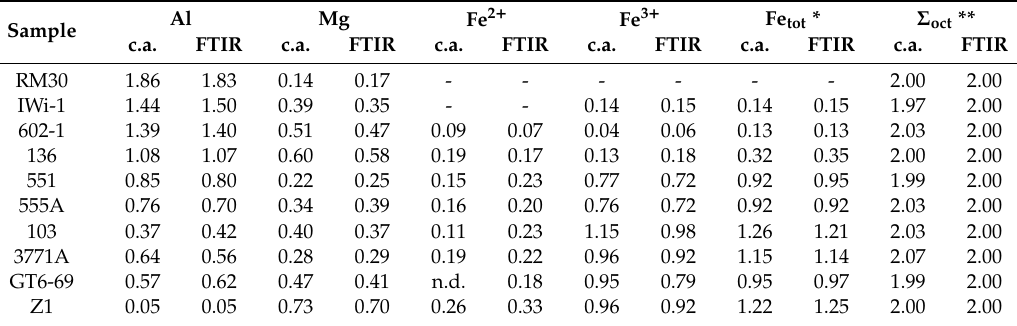
Table 6. Octahedral cation compositions of selected samples (cations p.h.f.u. ): c.a.—obtained from chemical analysis data; FTIR—calculated from relative integrated intensities of OH-stretching